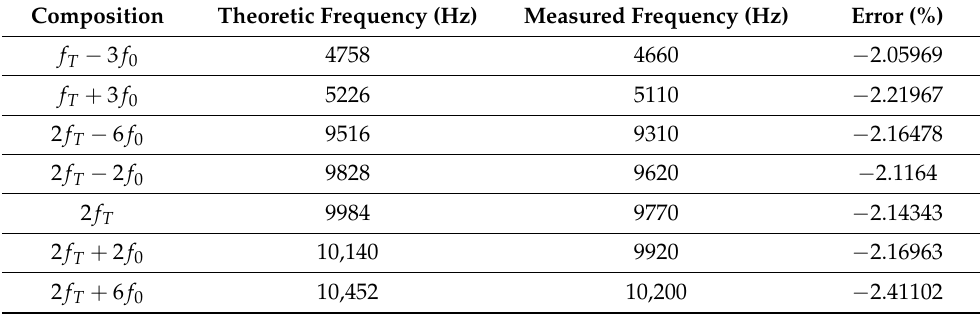
Table 2. Main vibration frequencies.